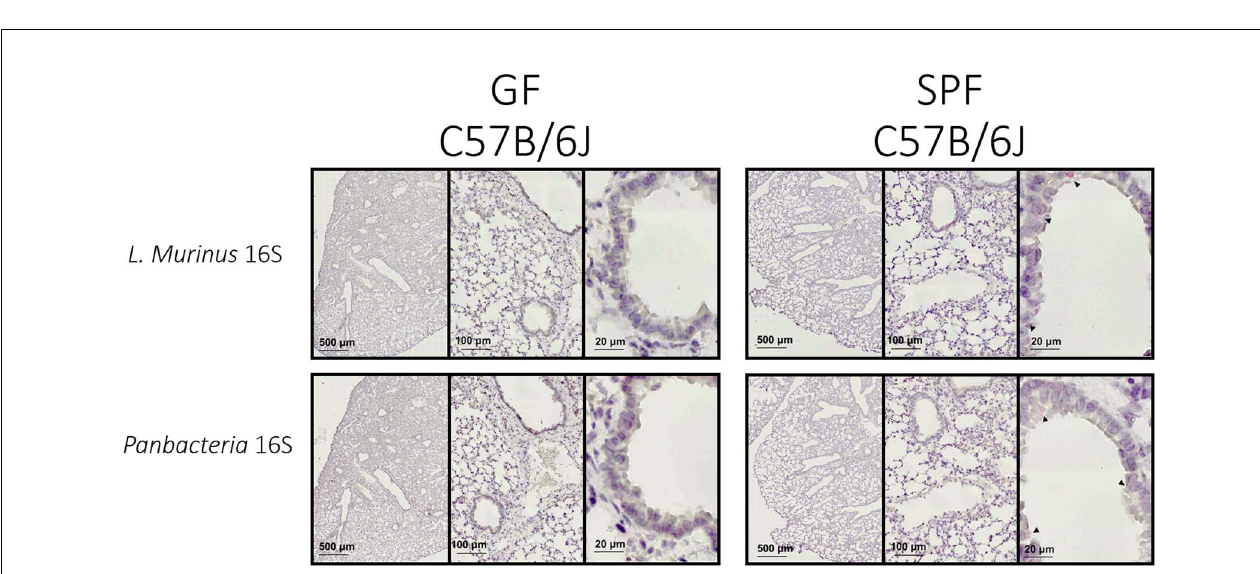
FIGURE 3 | Lung architecture with Giemsa staining—Sections obtained by performing transversal cuts of whole lung and visualized under a brightfield microscope with a 100 × /1.4 Oil objective.